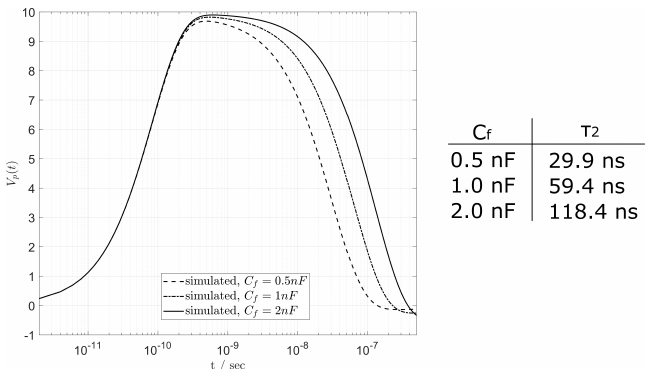
Figure 2. Simulation results of a discharge event.